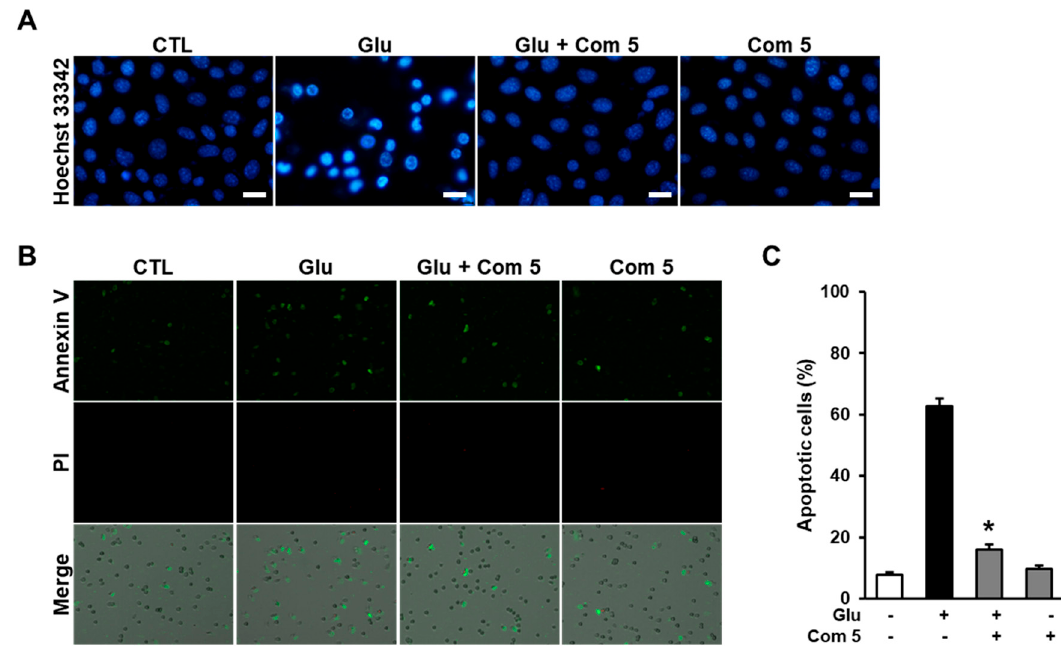
Figure 6. Glutamate-induced cell death was blocked by compound 5 (Com 5 ) in HT22 cells. ( A ) HT22 cells were stained with Hoechst 33342 after exposure to 5 mM glutamate in the presence of 12.5 µ M Com 5 for 10 h. Scale bars, 20 µ m. ( B ) HT22 cells were exposed to 5 mM glutamate in the presence of 12.5 µ M Com 5 for 10 h and stained with Alexa Fluor 488-conjugaged annexin V and PI. ( C ) Fluorescence images were analyzed using TaliPCApp software to determine the numbers of apoptotic cells. The bars denote the percentage of annexin V-positive (apoptotic) cells (mean ± S.E.M., * p < 0.05 compared with glutamate-treated cells). Image-based cytometric assays were done in triplicate and repeated at least three times.